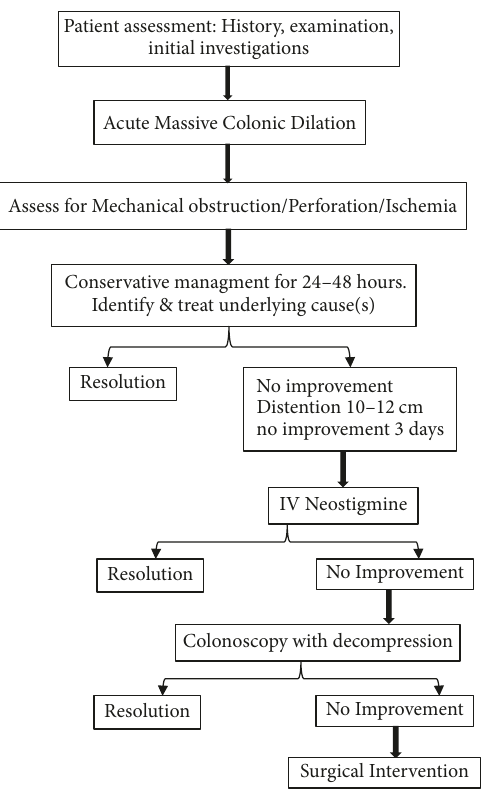
Figure 2: Stepwise approach to Ogilvie’s